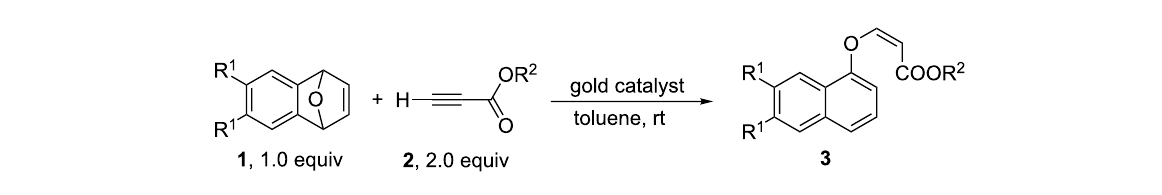
Entry a Au cat. Ag salt